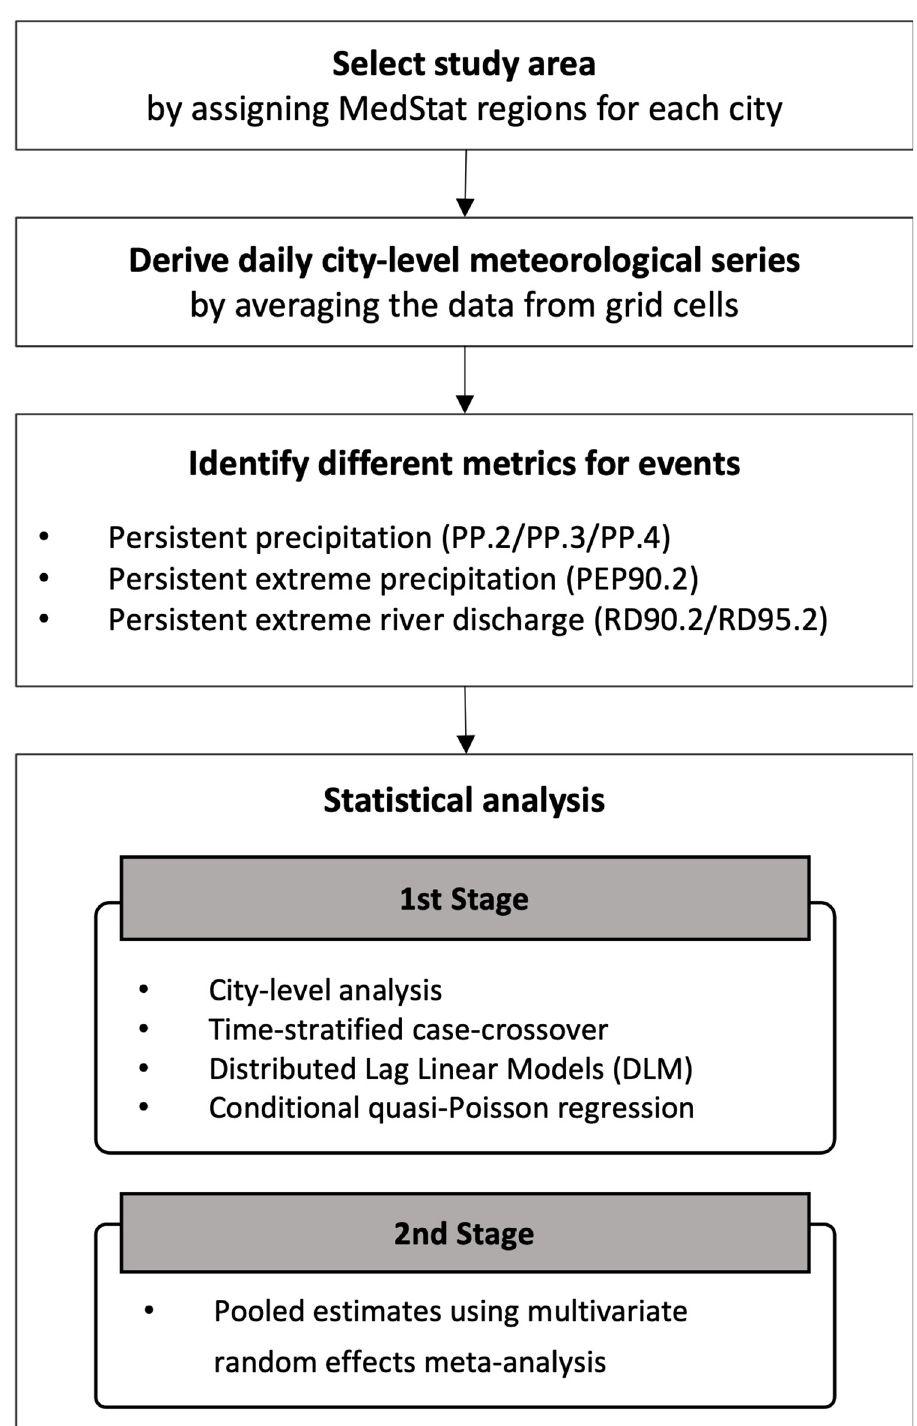
Fig 2. Diagram of research design and